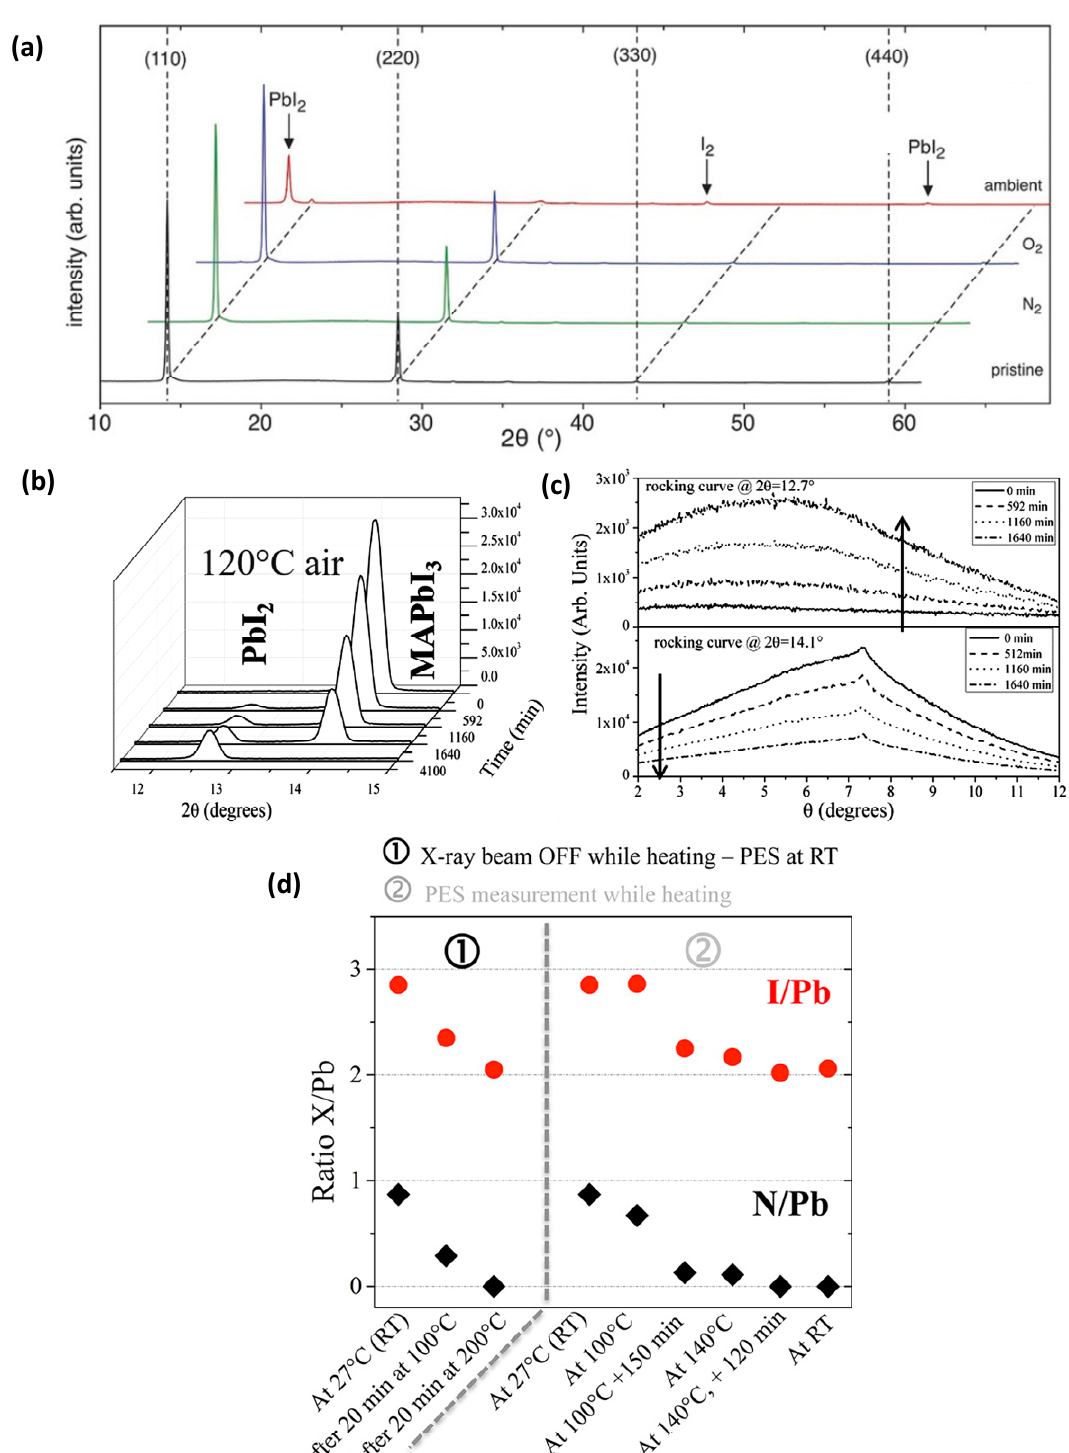
Figure 3. ( a ) XRD patterns of ITO/TiO 2 /perovskite samples heated at 85 °C for 24 h in different atmospheres. Reprinted with permission from [38]. ( b ) XRD patterns of MAPbI 3 film collected at 120 °C in air at different times and ( c ) the corresponding rocking curves at 2y = 14.11° and 2y = 12.71°. Reprinted with permission from [45]. ( d ) The atomic ratio of I/Pb (red circle) and N/Pb (black diamond) at elevated temperatures analyzed from photoelectron spectroscopy measurement. Reprinted with permission from [46]. Copyright (2015) American Chemical Society.